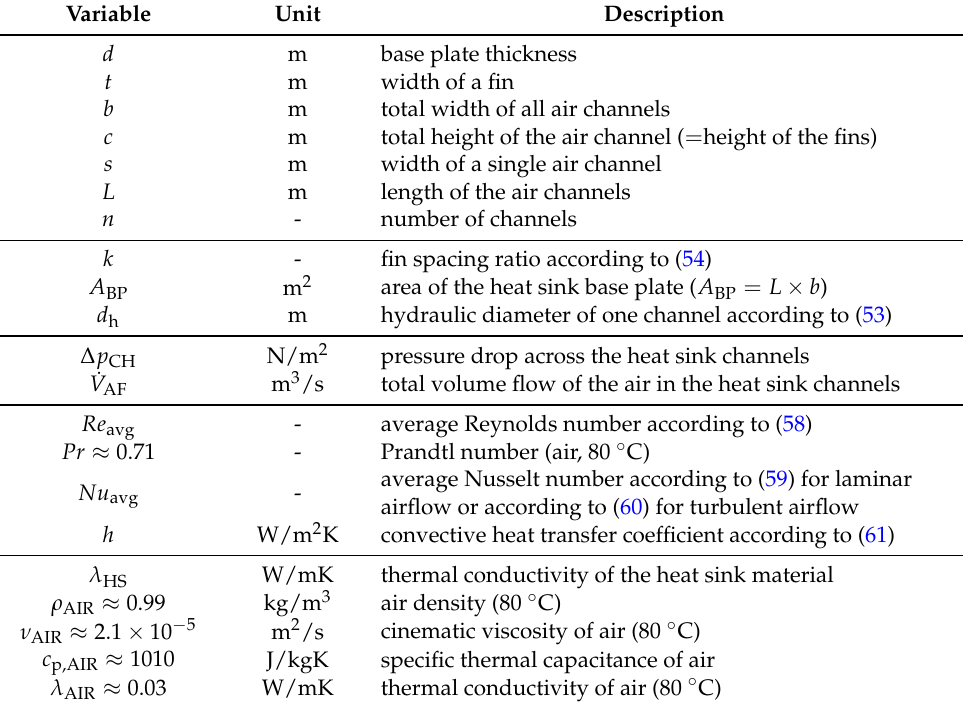
Table 2. Variables used for the calculation of the thermal resistance of a finned heat sink with fan, and for the calculation of the air flow rate in, and the pressure drop across the air channels of the heat sink. Variable